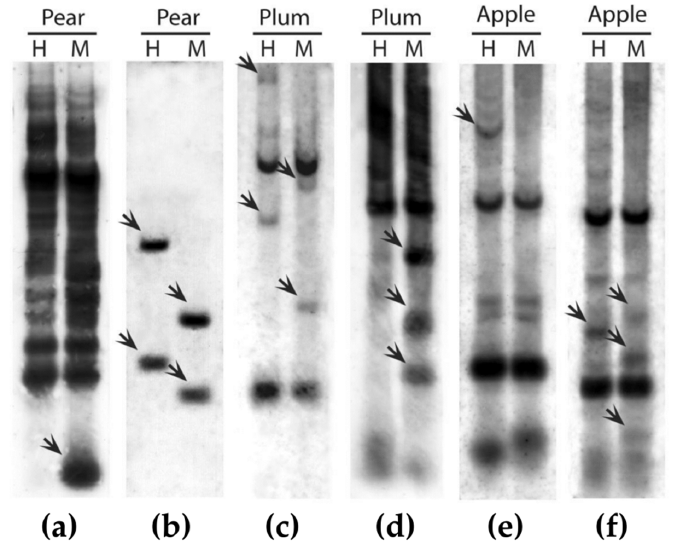
Figure 2. Gel blotting analysis of DNA methylation at the 5′CCGG sites detected by MSAP in the three fruit tree cultivars. Each DNA sample was digested with HpaII (H) and MspI (M), and the two digests were loaded on the gel side by side. The arrows indicate hybridization fragments that are discordant between the digests by the pair of isoschizomers, HpaII and MspI , and hence indicating differential DNA methylation between the inner and outer cytosines at the 5′-CCGG sites. The probes used for this experiment are sequenced MSAP fragments that are all the genic sequences MSAP50 ( a ), MSAP51 ( b ), MSAP13 ( c ), MSAP66 ( d ), MSAP53 ( e ) and MSAP 58 ( f ). The detailed information of these fragments is given in Table S2.